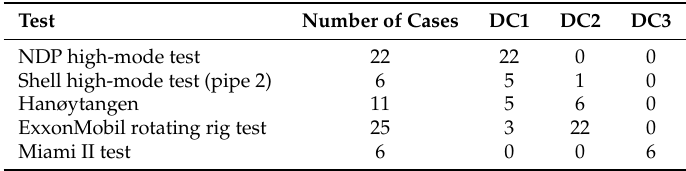
Table 3. Results of Gaussian mixture clustering